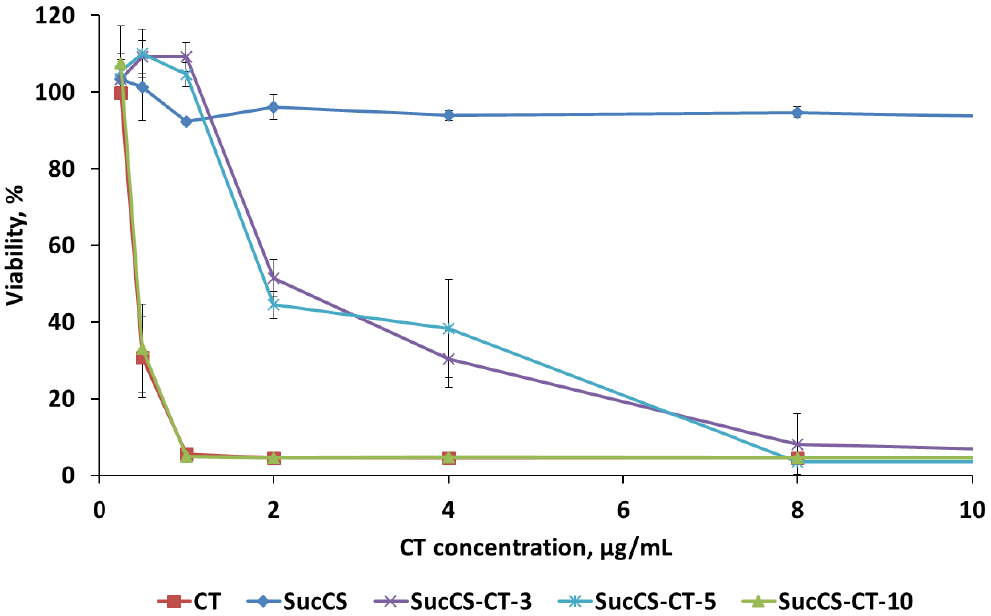
Figure 6. Antibacterial activity of succinyl chitosan-colistin conjugates against P. aeruginosa . Each point is represented as the mean of measurements ± SD.